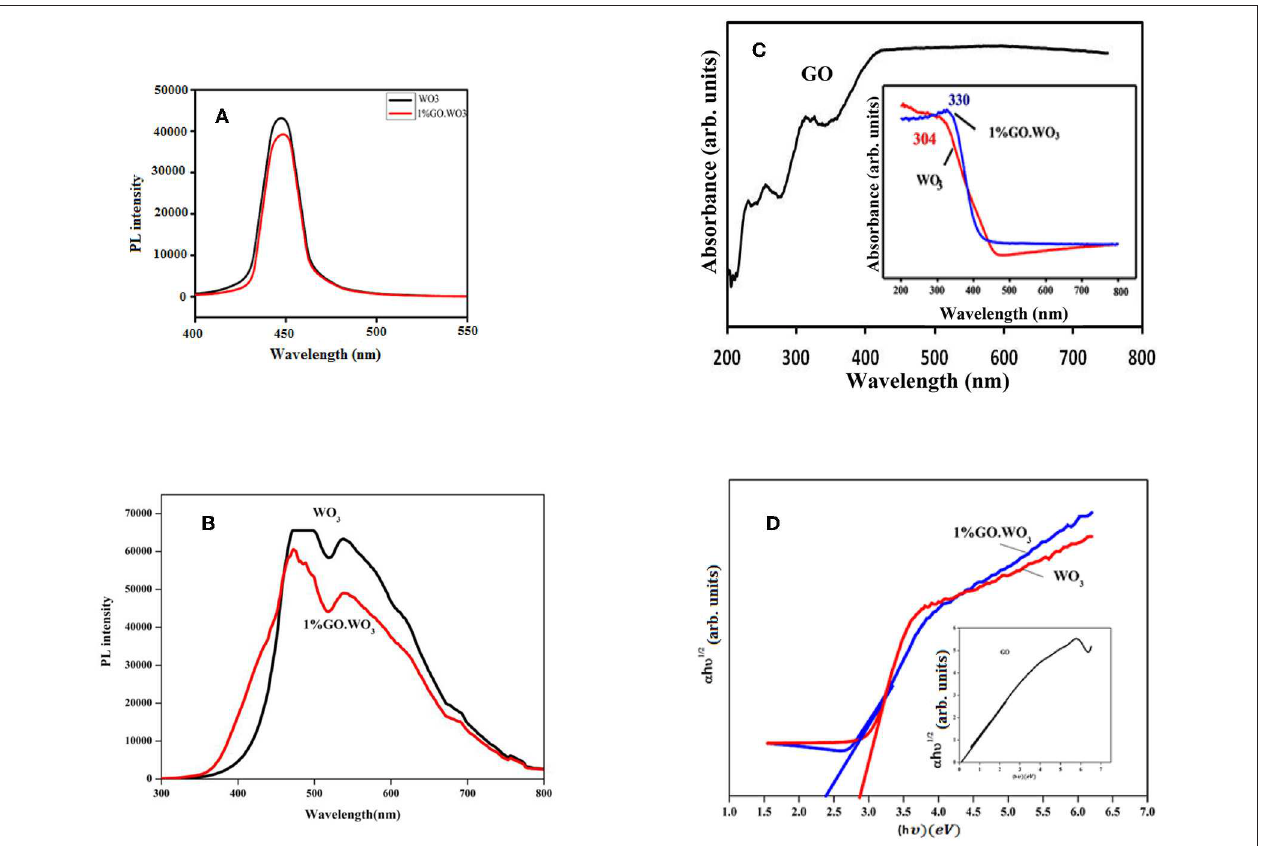
FIGURE 5 | Photoluminescence (PL) emission spectra of WO 3 and 1%GO.WO 3 in the margin of 400–550nm (A) , WO 3 and 1%GO.WO 3 in the margin of 300–800nm all excited at 320nm (B) , beside UV-visible spectra (C) , and gap energy plots (D) of the GO (inset), WO 3 , 1%GO.WO 3